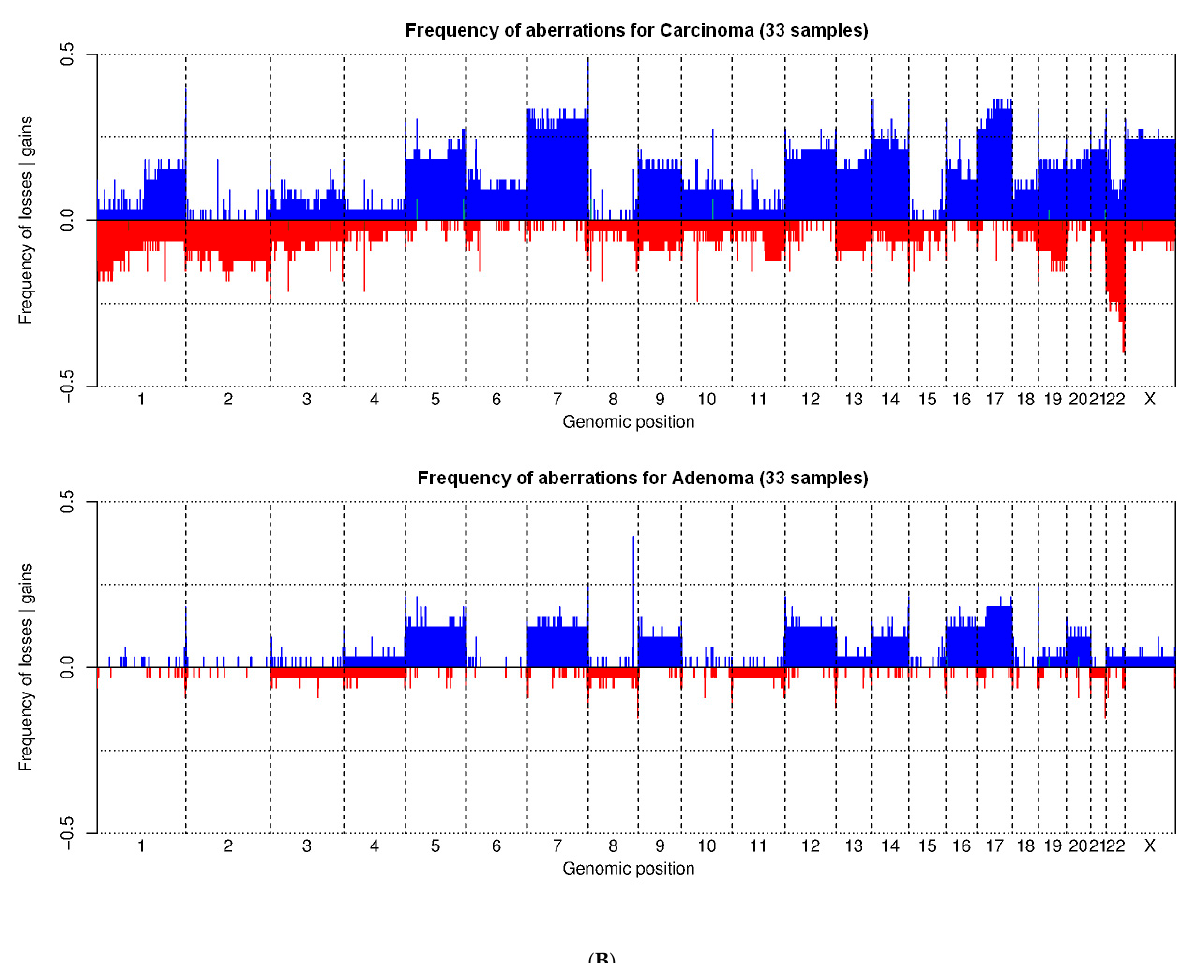
Figure 2. ( A ) Global heatmap of 66 clustered samples (training set: 33 cFTCs and 33 cFAs) using the Pearson distance and Ward’s method. Each row represents a patient, and each column represents a chromosome. ( B ) Frequency plots of gains and losses for each chromosomal region of 66 samples. The red- and blue-colored bars correspond to the percentage of samples with losses or gains, respectively, at each indicated region. Abbreviations: Adenoma: classic follicular adenoma (cFA); Carcinoma: classic follicular thyroid carcinoma